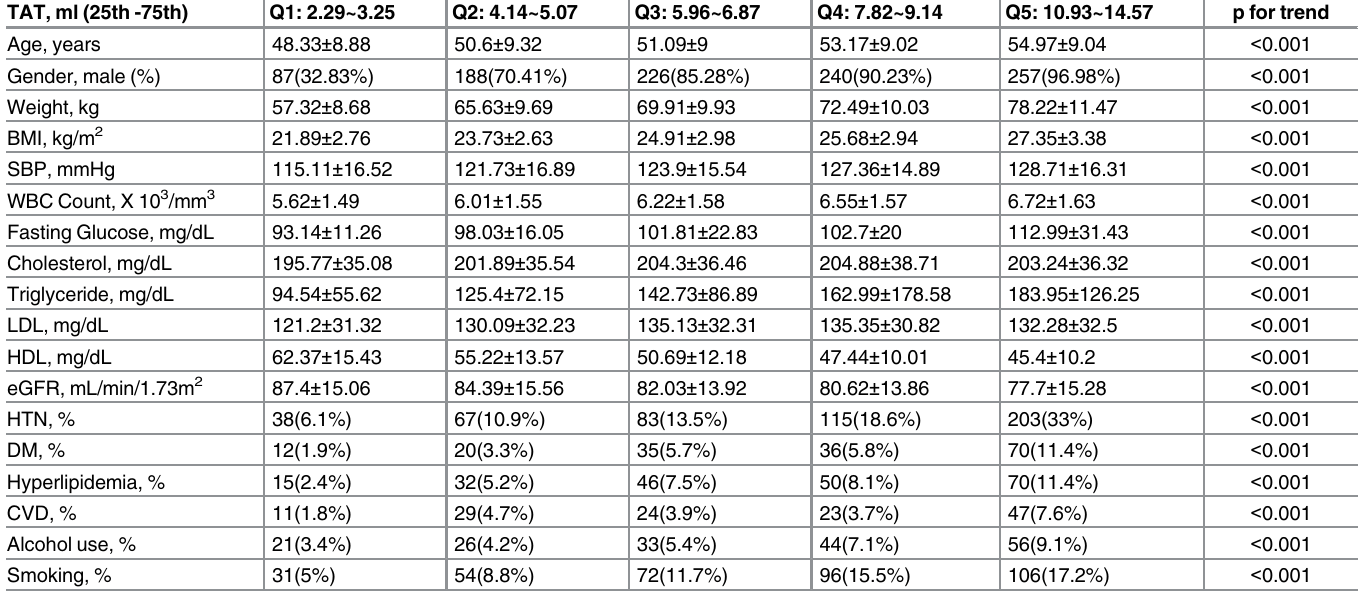
more leftward axes of P, QRS and T waves. Per 50ml increase of PCF is associated with 6.2ms increase in PR interval, nearly 2.5ms increase of QRS duration, and a leftward QRS axis devia- tion of 8.9degree (all p < 0.001), with per 5ml increase of TAT is associated with 5.8ms increase in PR interval, 2.1ms increase of QRS duration, and a leftward QRS axis deviation of 8.96 Table 2. Baseline demographic data of all study subjects based on visceral adiposity (PCF and TAT) stratification in current study. TAT, ml (25th -75th) Q1: